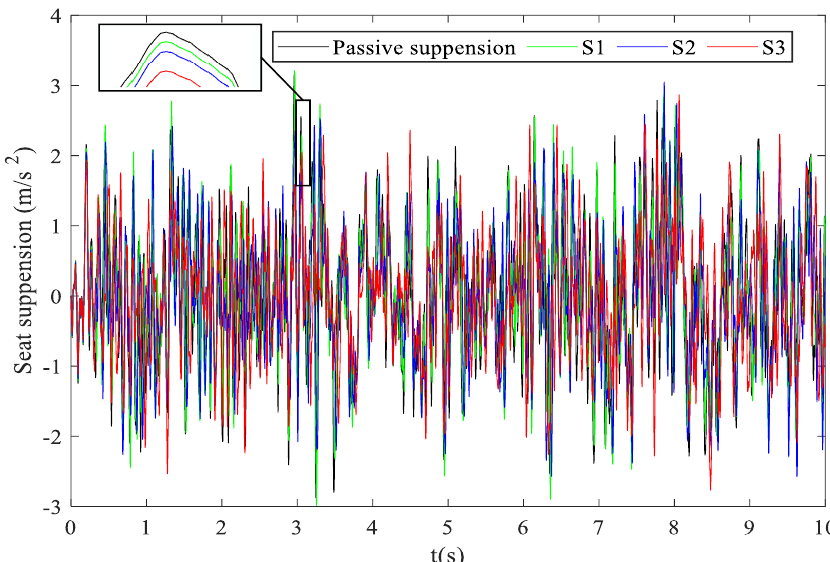
Figure 6. Comparison of the seat accelerations in the time domain.